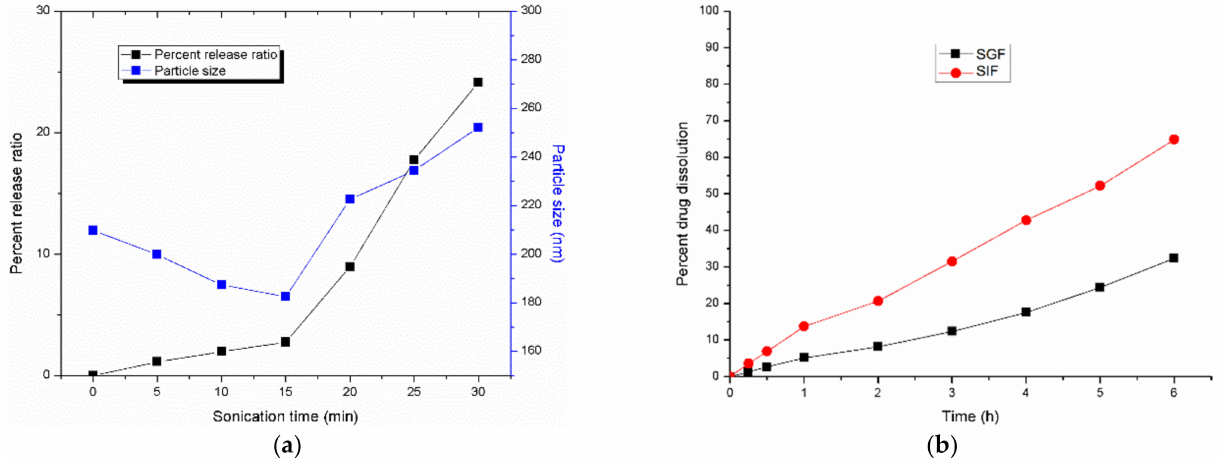
Figure 6. ( a ) Effect of ultrasound on the stability of ibrutinib nanoliposomes; ( b ) effect of dissolution medium on the in vitro release of ibrutinib